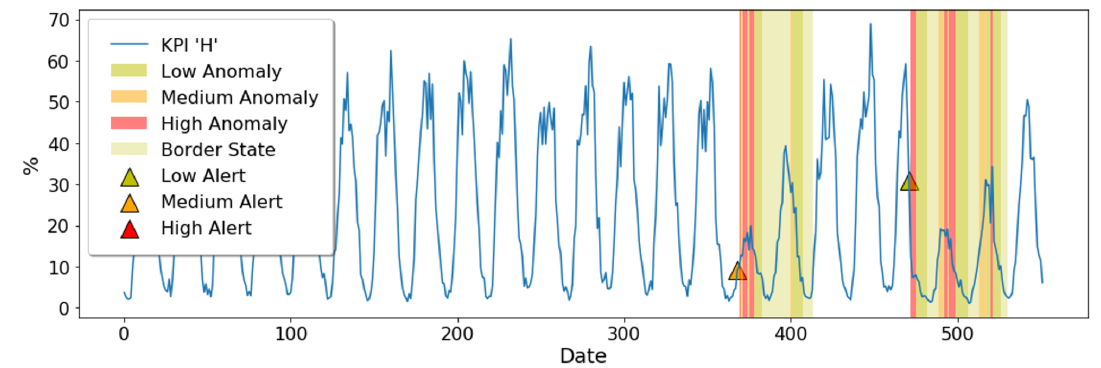
Figure 5. Example of visualization of the graphical user